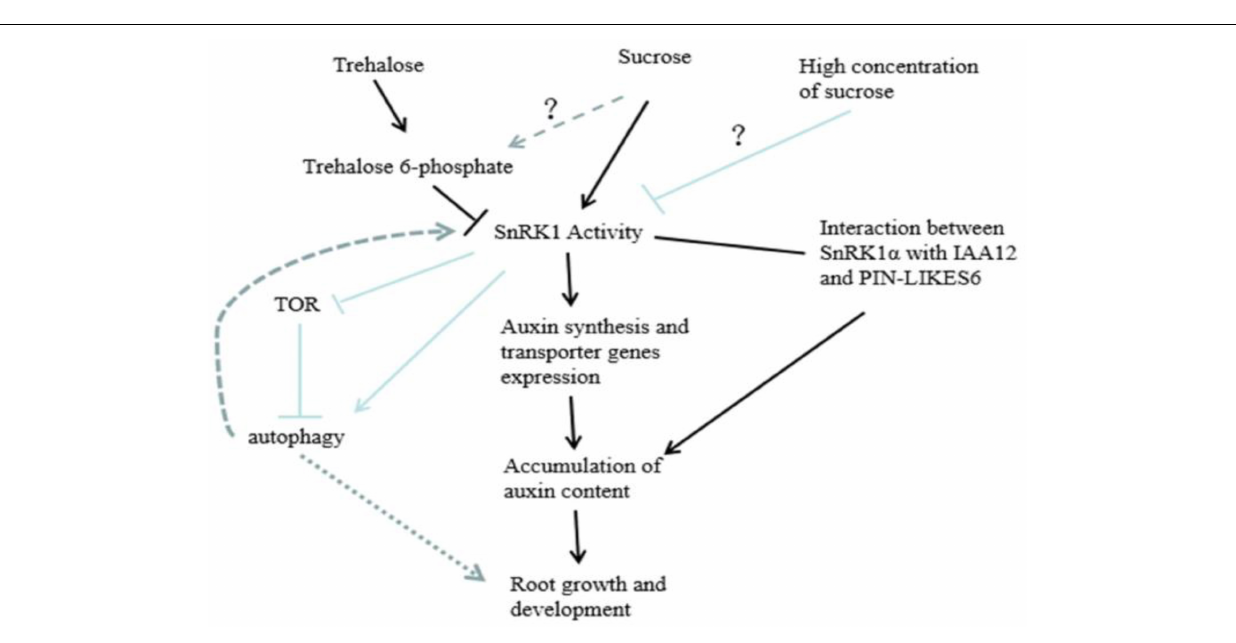
FIGURE 11 | Proposed model showing how peach PpSnRK1 participates in sucrose-mediated root growth through auxin